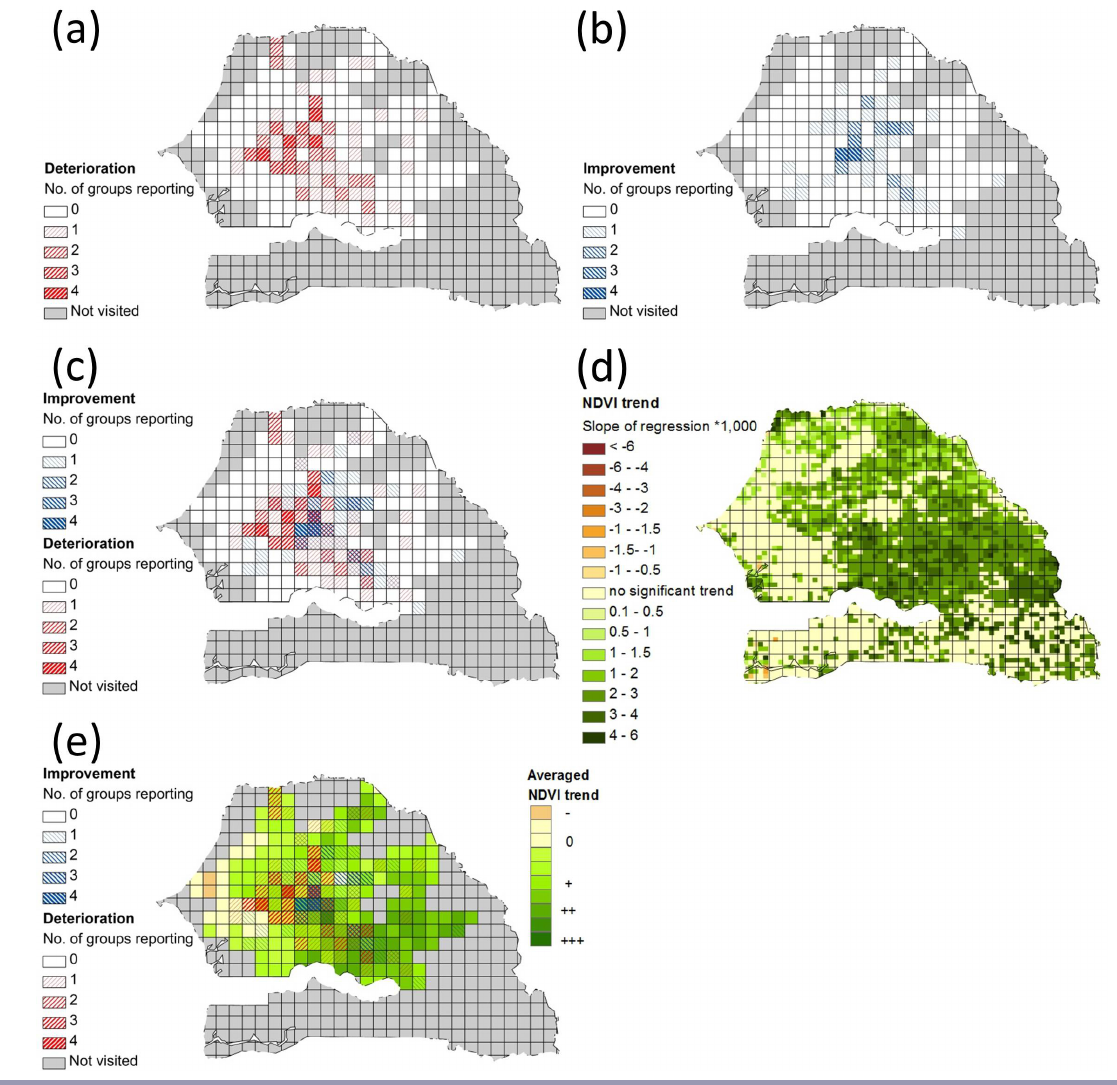
Fig. 4. Spatial representation of people’s perceptions of changes in vegetation cover and NDVI trends (by 20 × 20 km grid cells). (a) Number of focus groups reporting observations of degradation of the vegetation cover. (b) Number of focus groups reporting observations of rehabilitation/improvement of the vegetation cover. (c) Observations of degradation and improvement combined. (d) NDVI trends for 1982–2008 at the original 8 × 8 km resolution. (e) Observations superimposed on NDVI trends averaged for 20 × 20 km grid cells. Gray grid cells represent the area of Senegal that was not crossed by any of the mapped routes of transhumance and was hence excluded from the